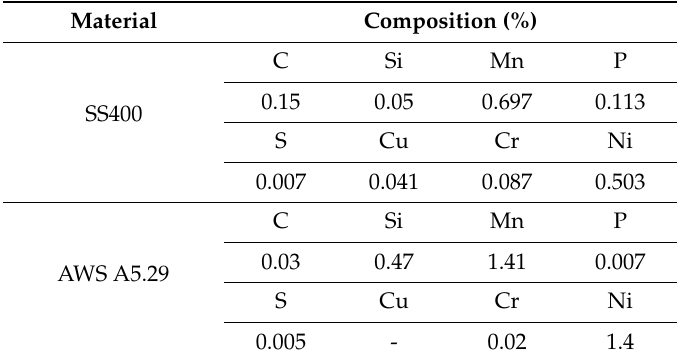
Table 2. Chemical composition of the base metal and filler metal used.